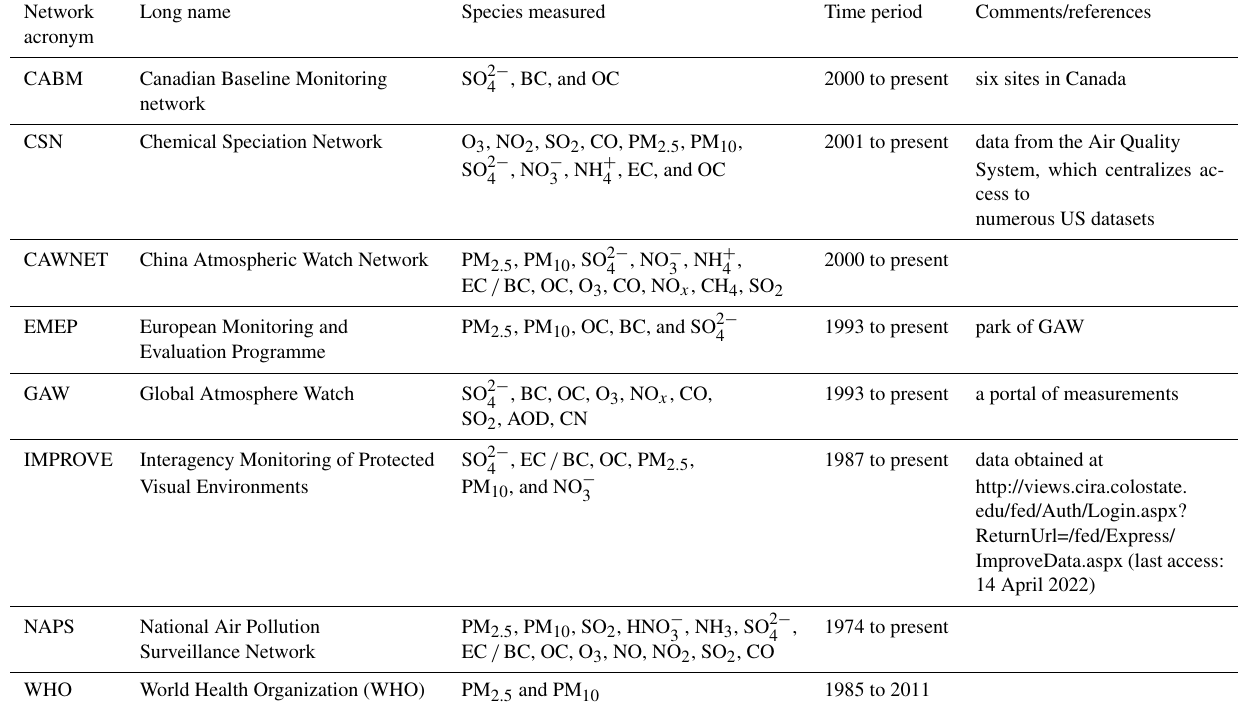
Table B2. Information about SLCF measurements from monitoring networks used for model evaluation in the Northern Hemisphere.